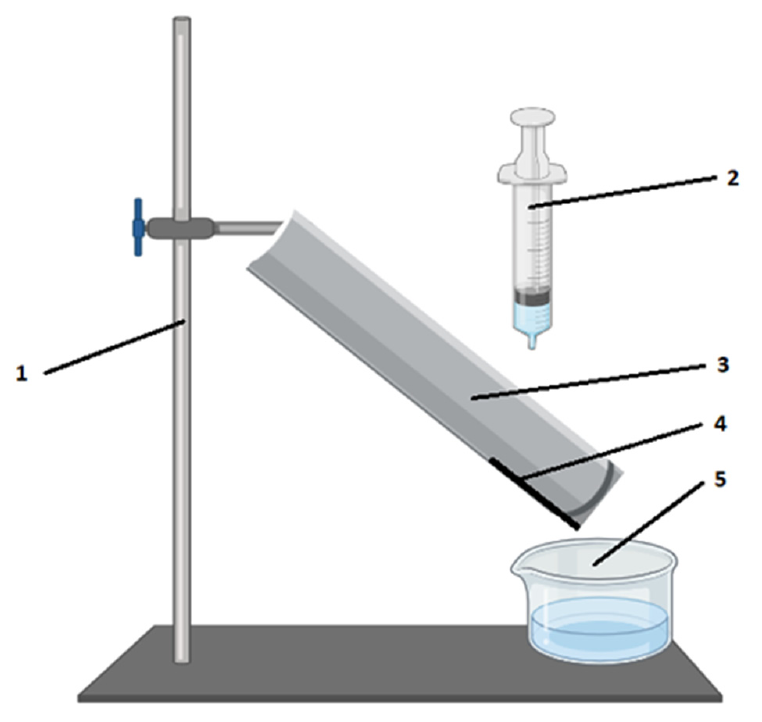
Figure 1. Setup for wettability measurements. 1—metal base for fixing the gutter at an angle of inclination (45 ◦ ); 2—a syringe with a volume of (10 ± 0.5) mL with a needle with an inside diameter (0.8 ± 0.02) mm; 3—rigid semi-cylindrical PVC gutter with an internal diameter (70 ± 5) mm and length (190 ± 5) mm; 4—tested sample; 5—a beaker with measurement liquid. [Figure prepared by using Professional version of BioRender Program].